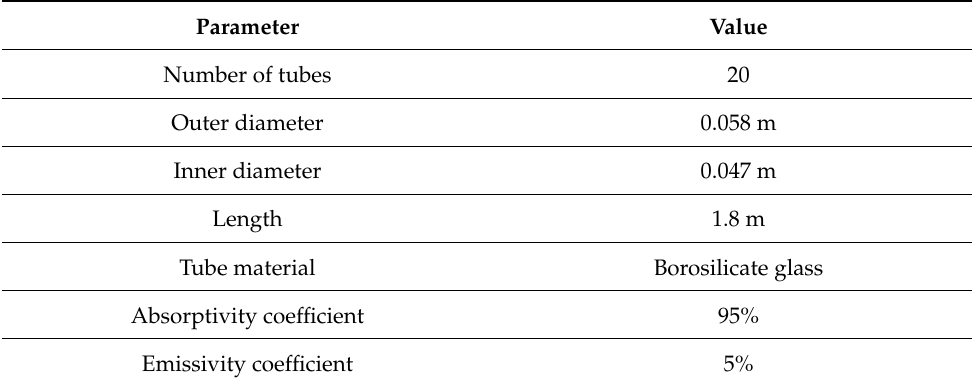
Table 1. Features of the evacuated tube of the solar